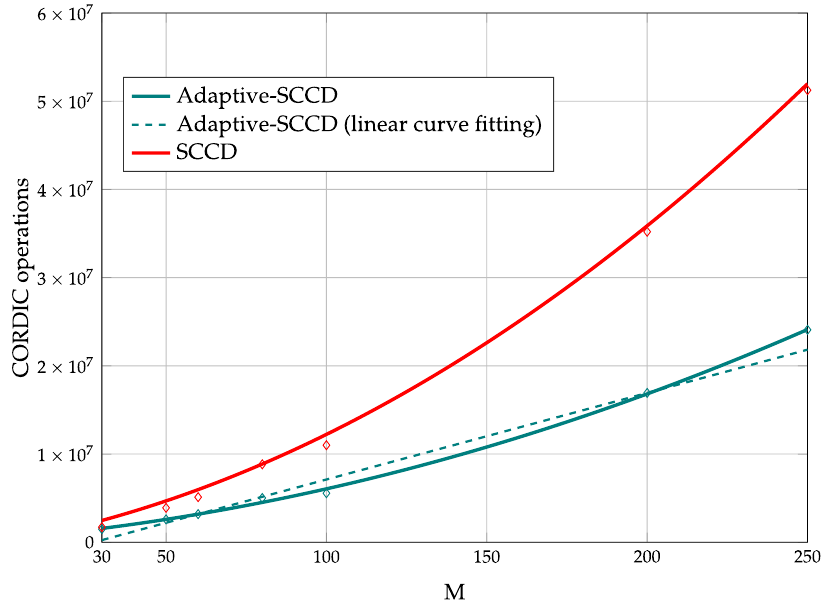
Figure 5. CORDIC operations versus M for a scenario with SNR = 10 dB, p = 5 normalized frequencies, and ∆ f coarse = 1/4 M . For analyzing the complexity of the algorithms, a second-order polynomial in M was used. In addition, a linear fitting is also provided for